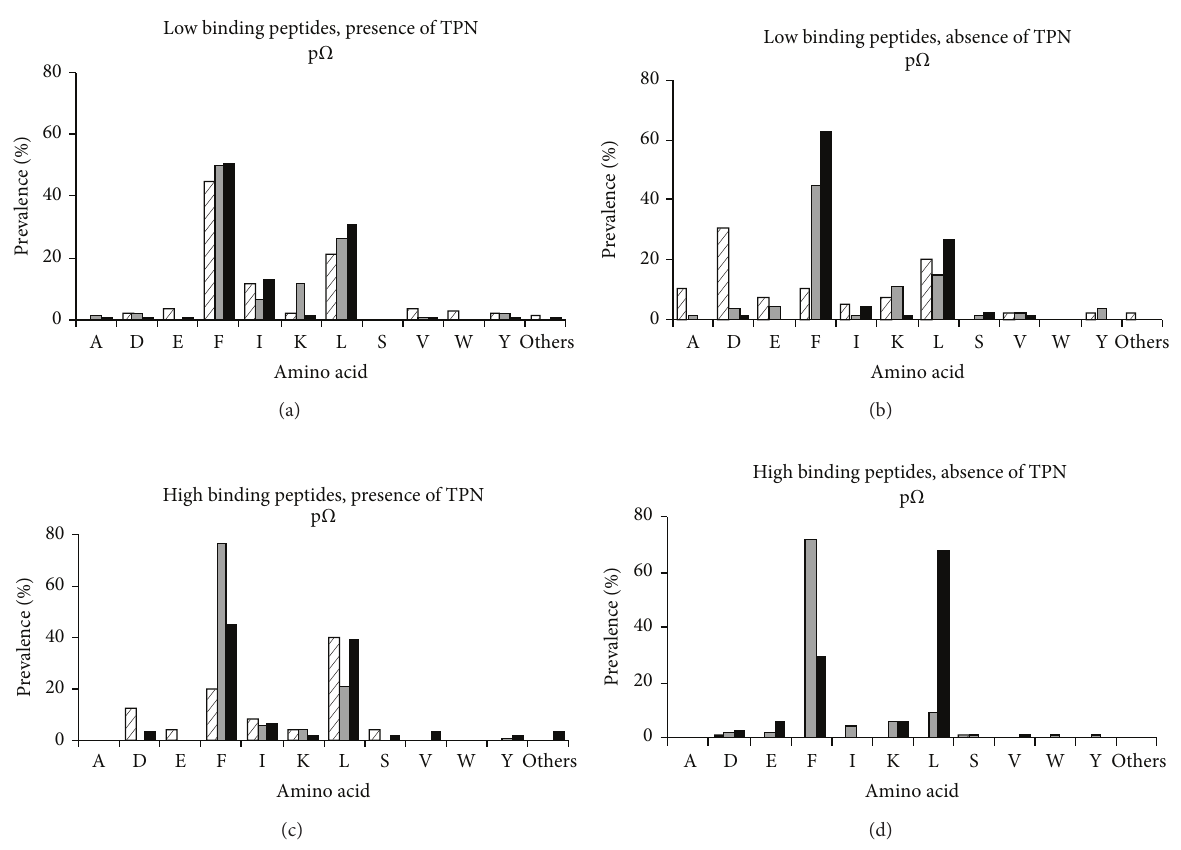
Figure 7: Frequency of amino acids occurring at p Ω in peptides eluted from HLA-A ∗ 24/156 variants. 𝑥 -axis represents AA residues at p Ω occurring in sHLA-A ∗ 24:02 (crossed bar), sHLA-A ∗ 24:06 (grey bar), and sHLA-A ∗ 24:13 (black bar). 𝑦 -axis represents percentage prevalence of individual residues at p Ω .